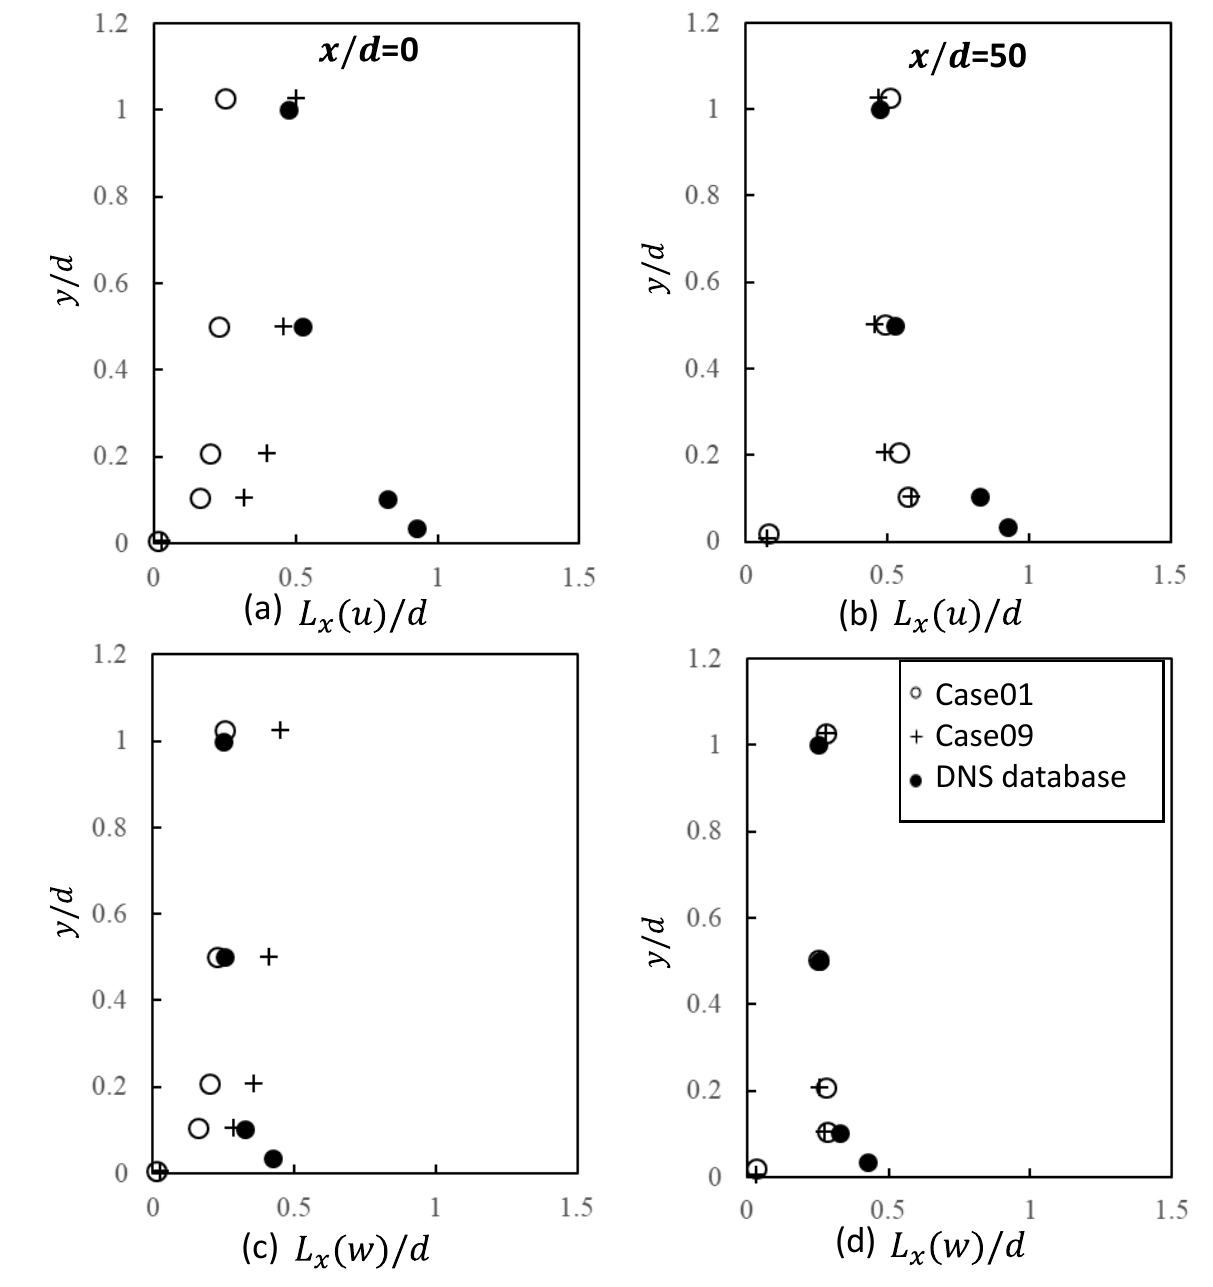
Figure 12. Longitudinal integral length scale profiles at the inlet section ( a , c ) and at x / d = 50 ( b , d ), L x ( u ) / d : ( a , b ), L x ( w ) / d : ( a , b ). In the figure, ( a ) denotes longitudinal integral length scales of the streamwise velocity component at inlet section, ( b ) longitudinal integral length scales of the streamwise velocity component at x / d = 50, ( c ) longitudinal integral length scales at the inlet section of the spanwise velocity component, and ( d ) longitudinal integral length scales of the spanwise velocity component at x / d = 50, ( ◦ : Case01, + : Case09, • : DNS